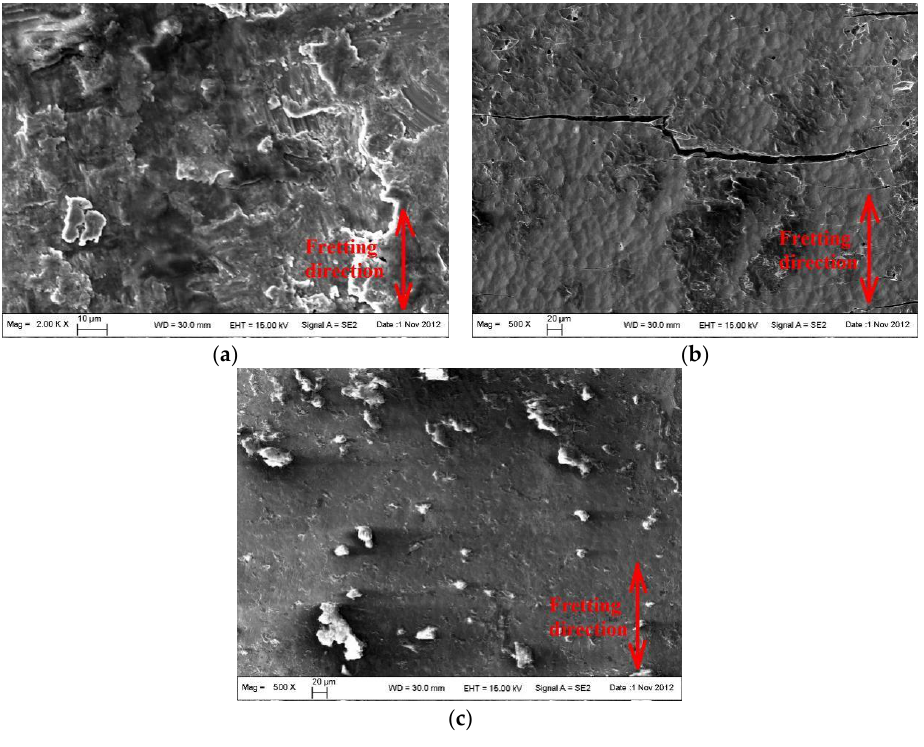
Figure 19. Fretting wear morphology of fretting fatigue specimens with different modifications after failure. ( a ) BM; ( b ) ZrN; ( c ) ZrN+SP.